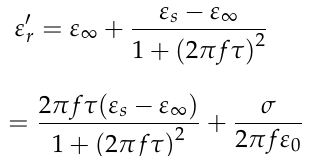
The unchanged C 0 forebodes the powerful eddy-current loss in the microwave absorption process. In Figure 8a, here the continuous declining of C 0 in all samples indicates insignificant eddy current dissipation in these composites. The dominating absorption in C4 samples is attributed to dipole polarization produced by abundant defects as displayed in Figures 2b and 4e. Besides, the comprehensive judgment of microwave transmission capacity in absorbers could be characterized by attenuation constant ( α ), which is represented as following [47–49]: